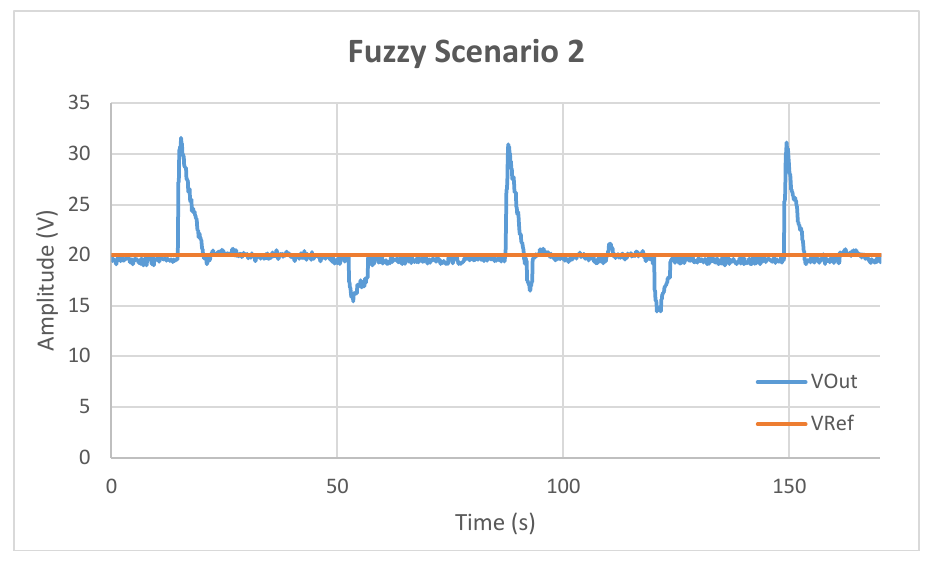
Figure 17. The response results of load changes with fuzzy logic controller.